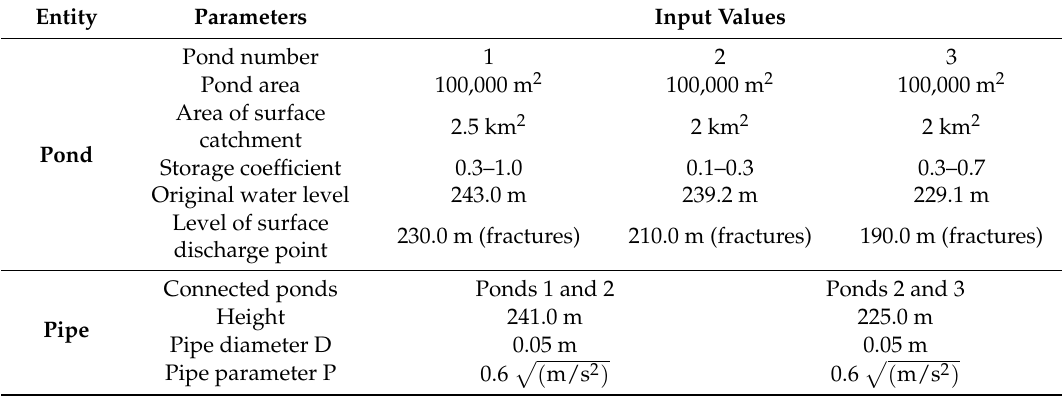
Table 5. Values input into the SIMPL program for prediction of the Dalsung copper mine groundwater rebound.